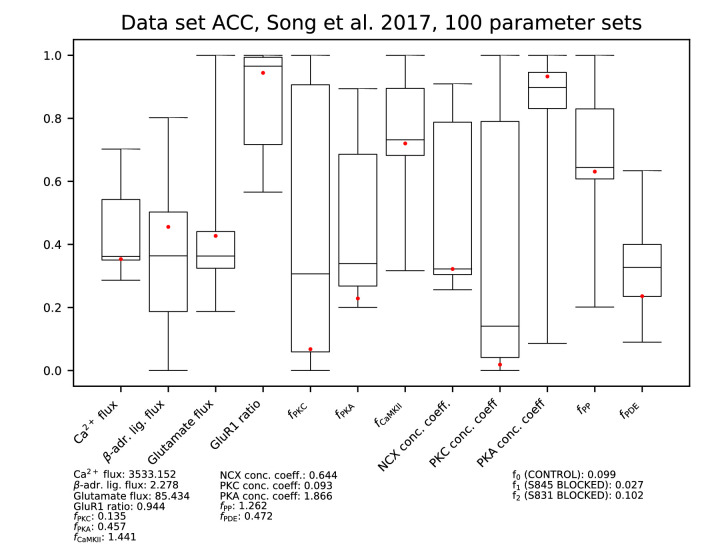
Parameters for data set ACC.See Figure 9—figure supplement 1 for details.